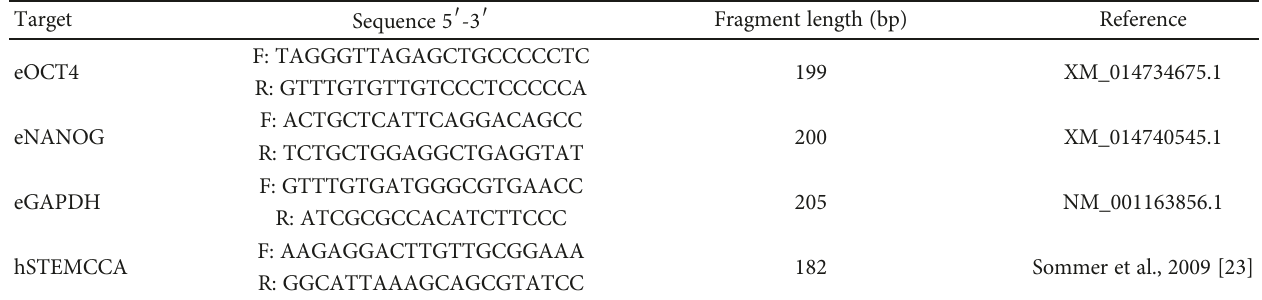
Table 1: Speci fi c equine primers used for the detection of endogenous and exogenous transcripts related to pluripotency and the reprogramming